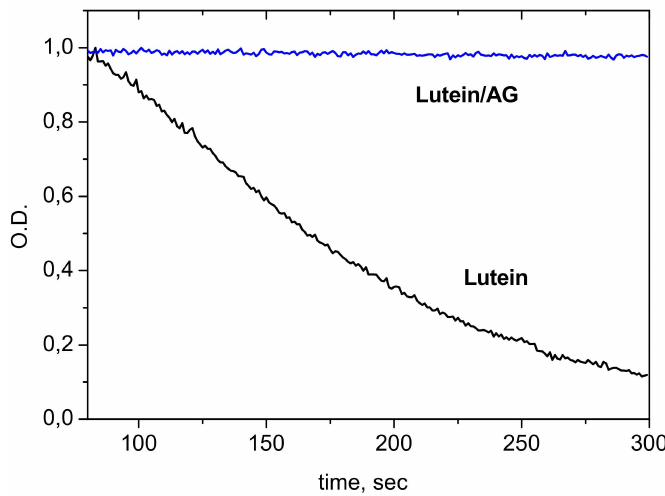
Figure 6. Oxidation of lutein and lutein / AG complex by ozone in 25% ethanol solution. Concentration of AG 0.05 mM (adopted from